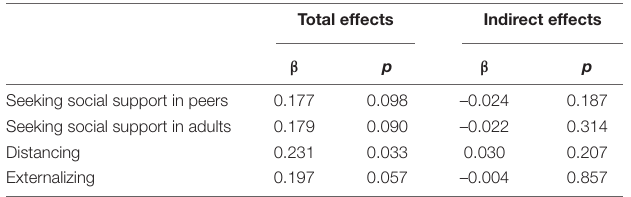
TABLE 2 | Total and indirect effects for relations between (a) negative emotions, news avoidance and reactive coping strategies.